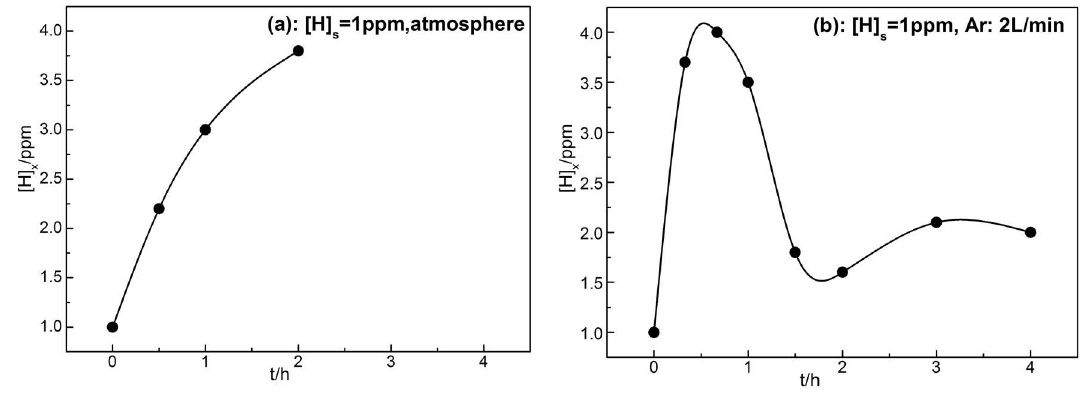
Figure1. Influence of atmosphere on hydrogen content in steel during ESR